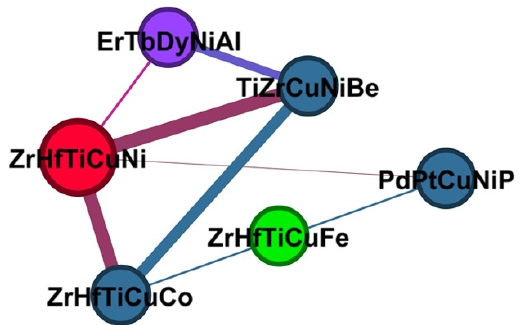
Figure 4. Part of the HEA interaction network with compounds neighbors. The ZrHFTiCuNi alloy is a sample with three of the most similar neighbors, as shown in dark blue.